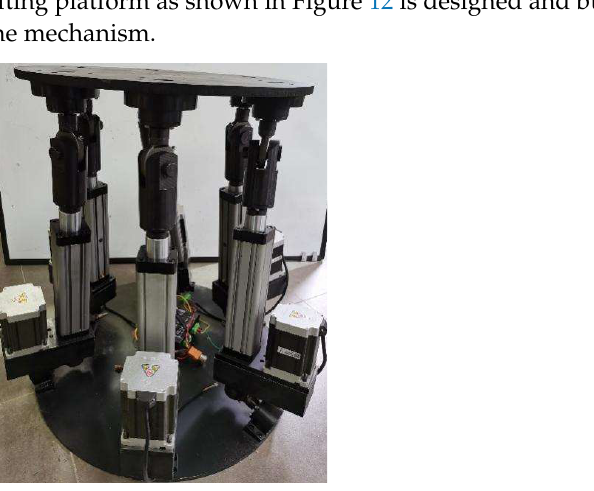
Figure 11. Stress curve of upper and lower platform hinges. ( a ) Stress curve of upper platform hinge. ( b ) Stress curve of lower platform hinge.